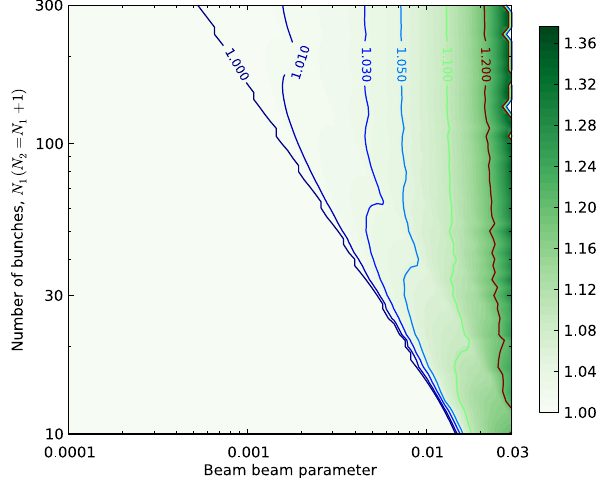
FIG. 4. The largest module of the eigenvalues of M T for different beam-beam parameters and number of bunches in ring one N 1 , while N 2 ¼ N 1 þ 1 , for the second-order moment case. Both tunes in two rings are optimized around 0.2 for each N 1